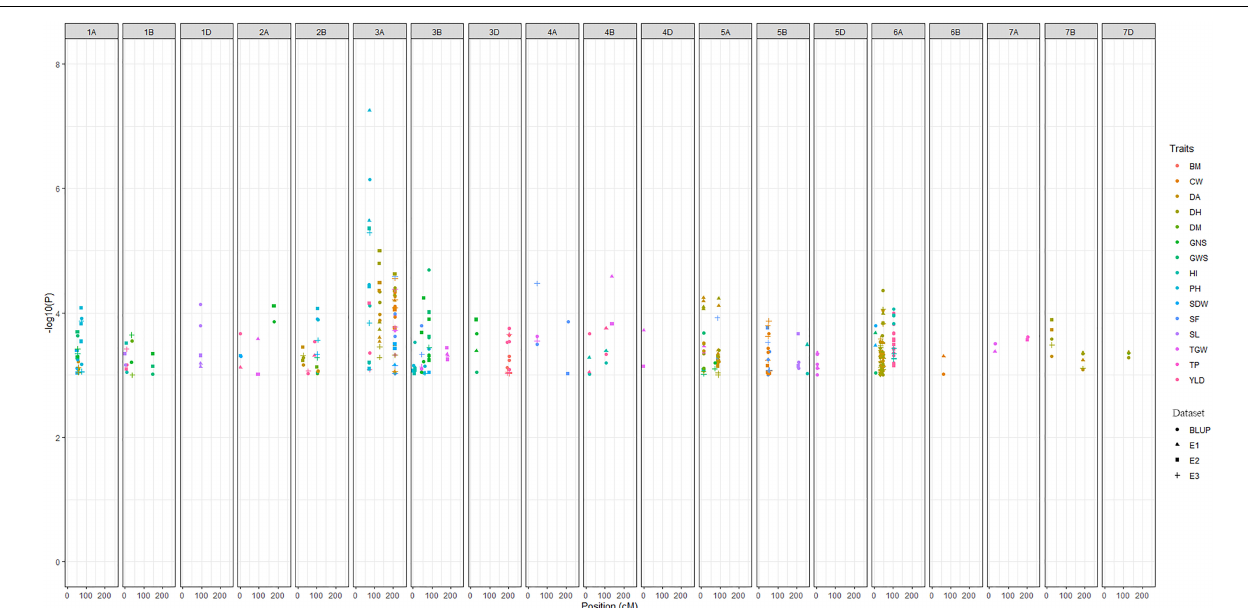
FIGURE 3 | Manhattan plot summarizing the significant MTAs reported for fifteen traits in four datasets. In figure, BLUP, Best Linear Unbiased Prediction; E1, the year 2016–2017; E2, the year 2017–2018; E3, the year 2018–2019; DH, days to heading; DA, days to anthesis; DM, days to maturity; PH, plant height; SF, spike fertility; CW, chaff weight; SDW, spike dry weight; SL, spike length; GNS, grain number per spike; GWS, grain weight per spike; TGW, thousand grains weight; GY, grain yield; TP, tiller per plant; HI, harvest index; BM,